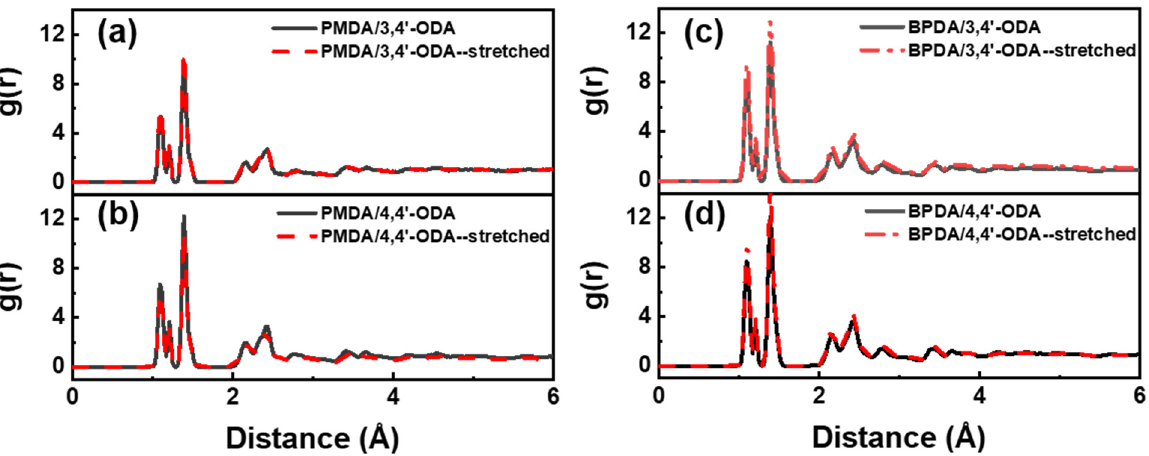
Figure 7. All-atom RDF of the systems before and after stretching. ( a ) PMDA/3,4 ′ -ODA; ( b ) BPDA/3,4 ′ -ODA; ( c ) PMDA/4,4 ′ -ODA; ( d ) BPDA/4,4 ′ -ODA.